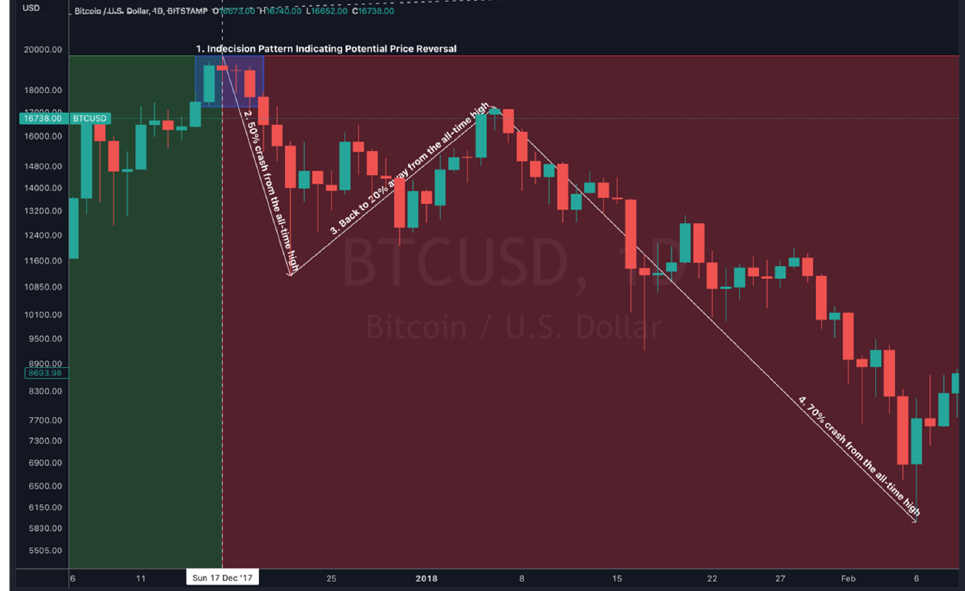
Figure 4. The first 4 sequences of the 2017 bear market during the Bitcoin 2016–2020 halving cycle. During this cycle, the Bitcoin price reached a new all-time high of $20,000 before entering the bear market. Figure 4 highlights 4 out of 5 primary sequences of events that are similar to Figure 2. A reversal pattern was first indicated at the new all-time high of $20,000. Then, Bitcoin suffered an approximately 50% crash to $11,000. The Bitcoin price recovered back to approximately 20% away from the historical all-time high ($17,000) before making a 70% crash away from the historical all-time high down to $6000.